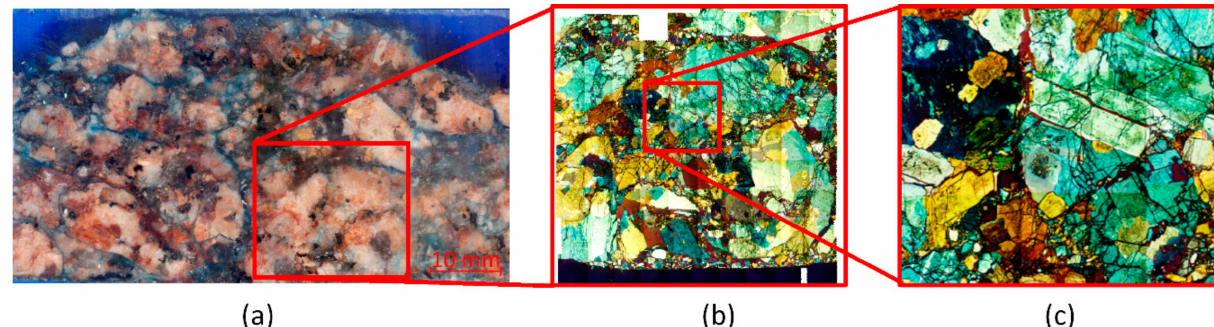
Figure 5. Details of the fixed particle bed: ( a ) Center section before thin section preparation; ( b ) Digitized part of the thin section; ( c ) Detailed view on inter- and intragranular cracks through the particles. Note that images ( b ) and ( c ) show the thin section under polarized